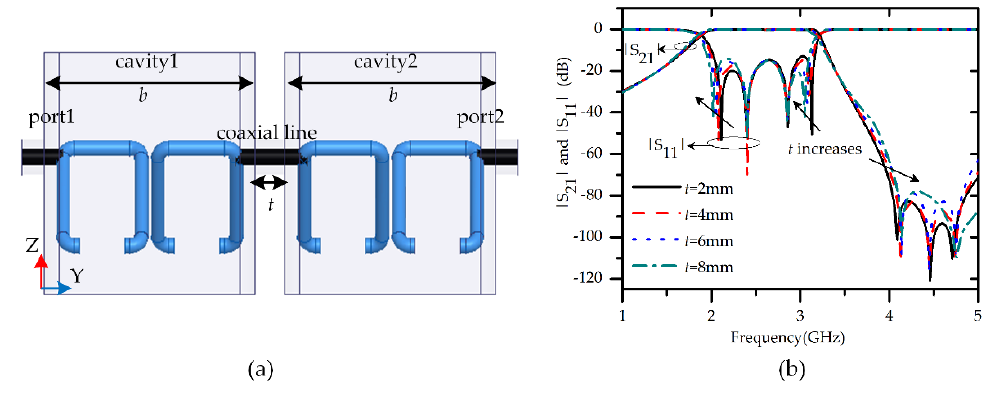
Figure 5. The proposed two-cavity multi-mode filter ( a ) structure; ( b ) t varies.